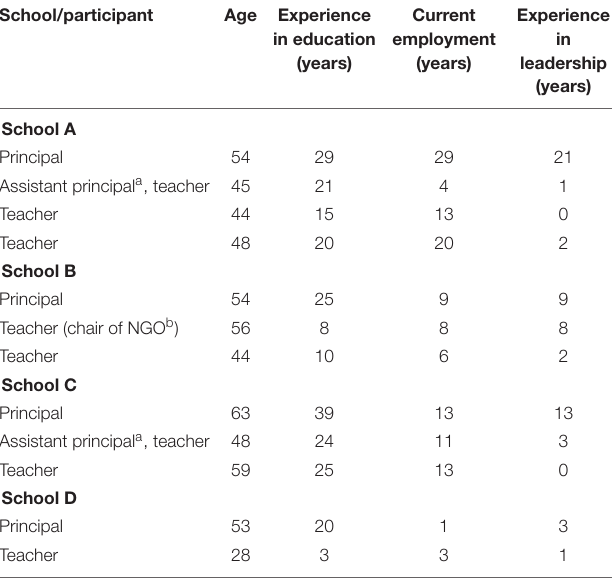
TABLE 3 | Background information of the